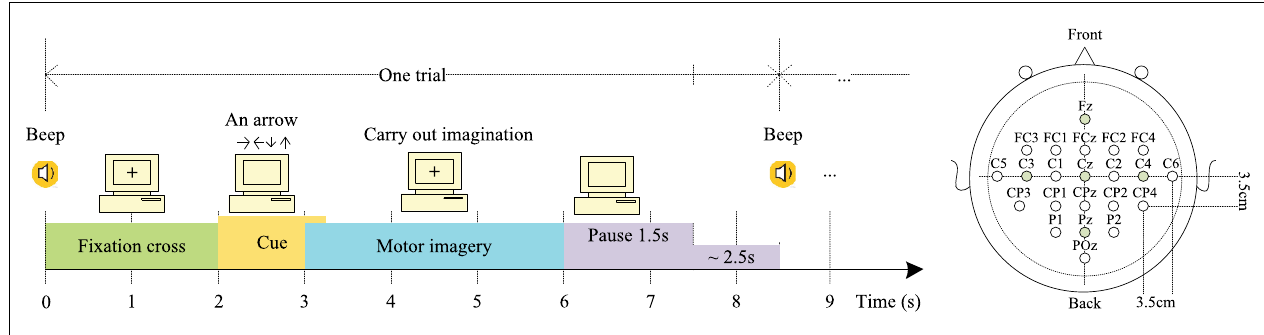
FIGURE 1 | Left: trial timing of the motor imagery paradigm. (Cued MI: left hand, right hand, both feet, tongue); Right: electrode montage corresponding to the international 10–20 system (adapted from Brunner et al.,